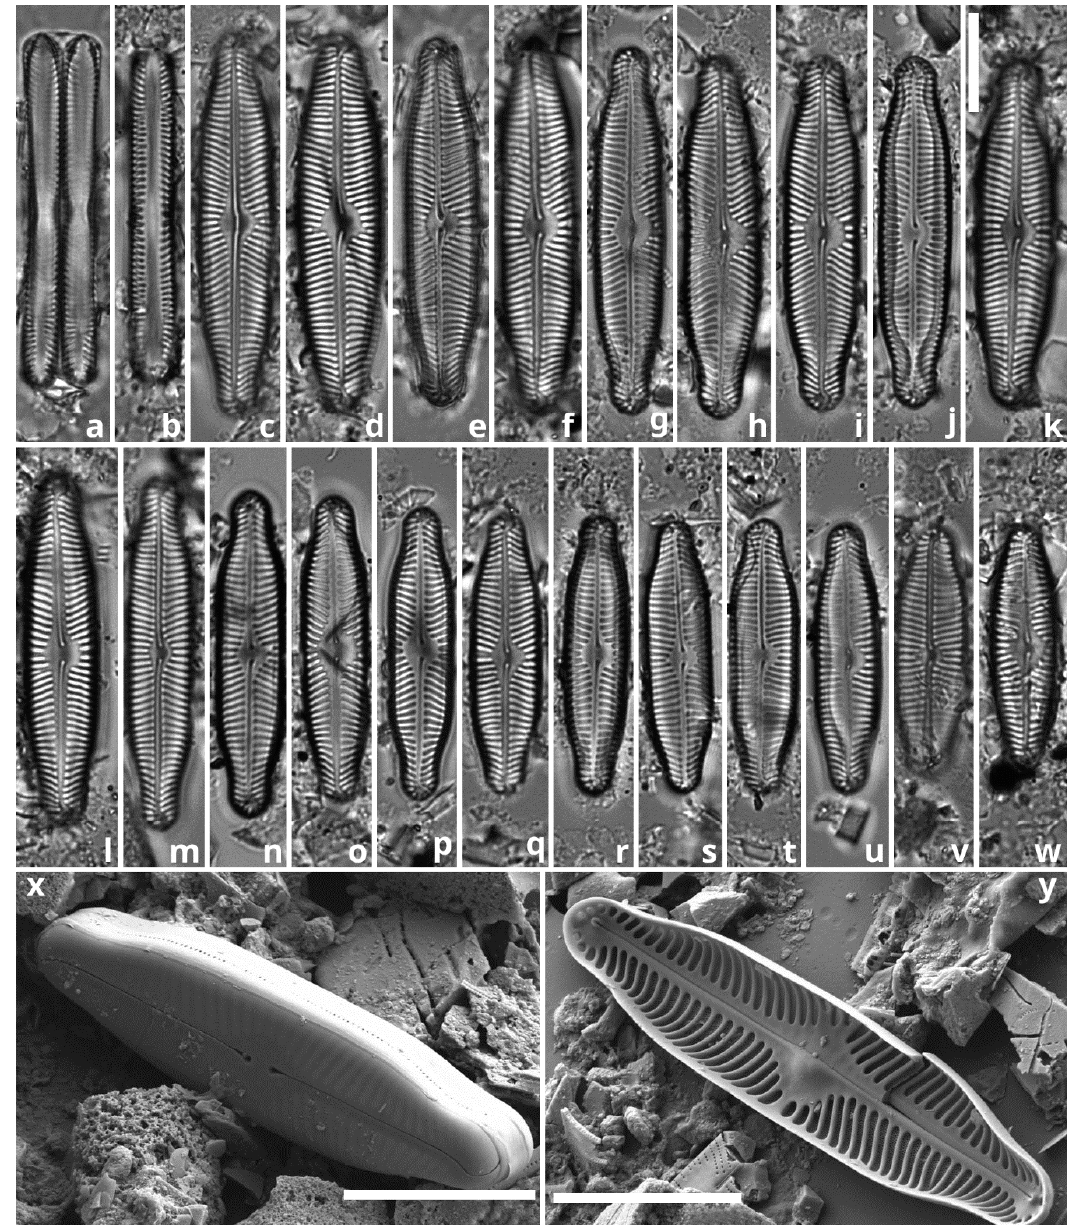
Figure 5. Pinnularia seignavouxensis , type population from Laqui de Seignavoux pond. ( a – w ): Light microscopy (LM) observations. ( x , y ): SEM illustrations of the individuals. Scale bar (white line) = 10 µ